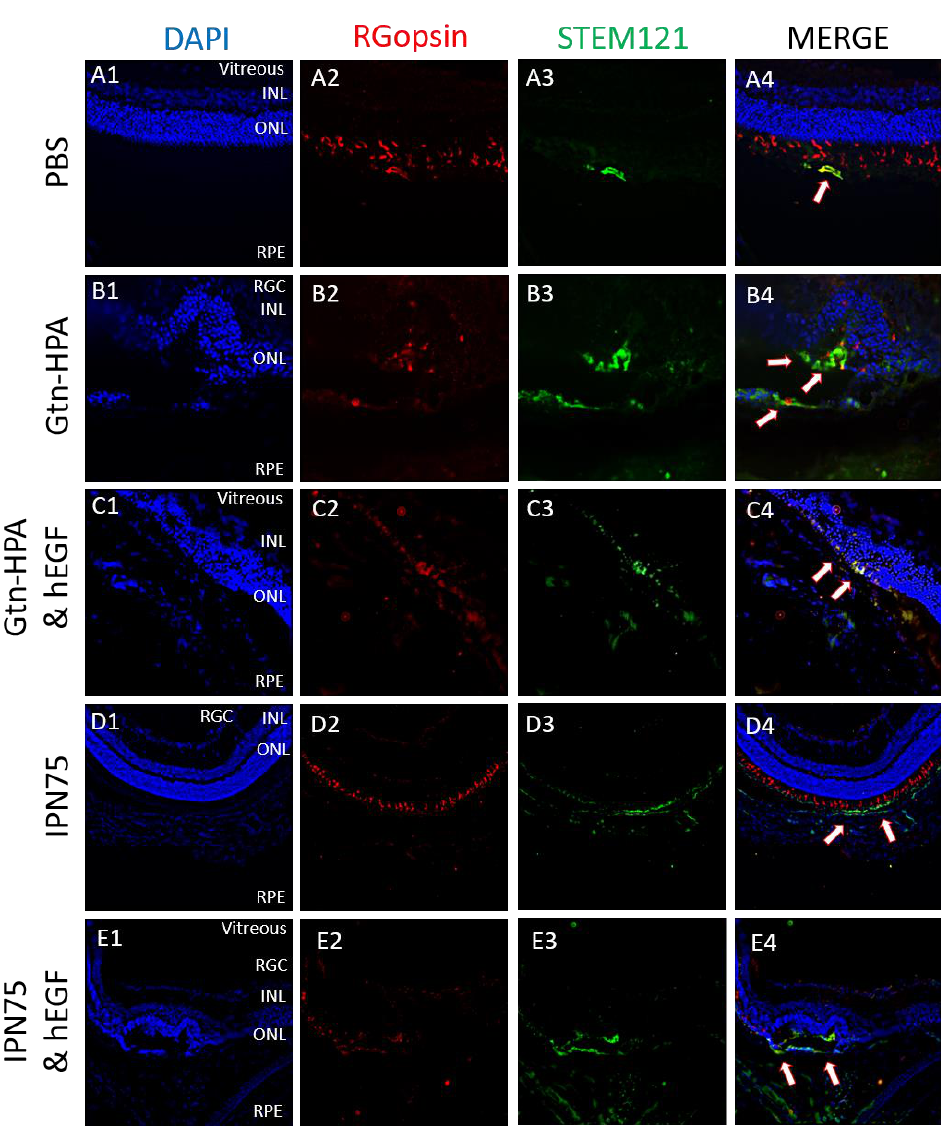
Figure 9. The 3-week transplantation of hRPC in IPN and PBS. hRPCs survived in immunosuppressed rats for 3 weeks following subretinal injection. All images were taken at 40X magnification. ( A2 – E2 ) are different test conditions stained with RG-opsin (red); ( A3 – E3 ) show STEM121 (green) staining. Nuclei are counterstained with DAPI in ( A1 – E1 ) and the last column ( A4 – E4 ) shows the merge overlay image. Red arrows show engrafted hRPCs aligned with DAPI near the ONL layer. Scale bar: 200 µm.